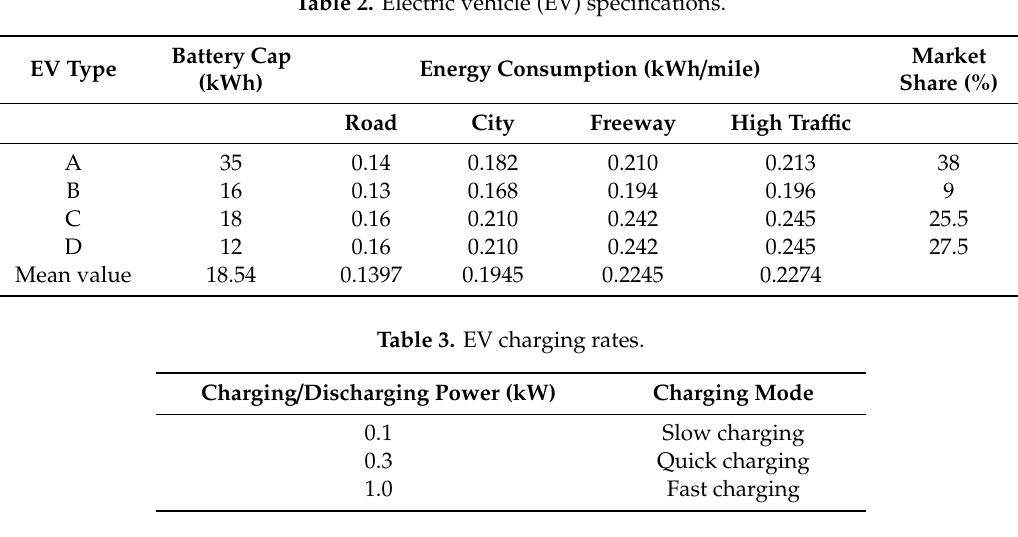
Table 2. Electric vehicle (EV) specifications.